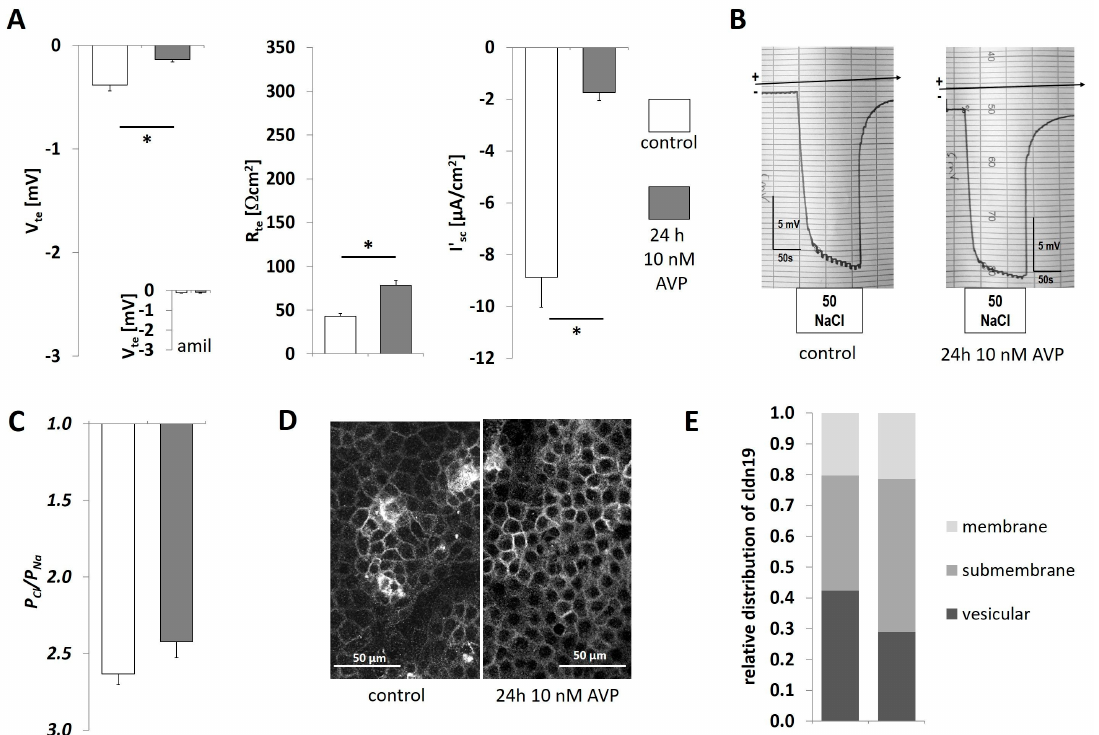
Figure 4. 600-IMCD under AVP stimulation (10 nmol/L). ( A ) Electrophysiological properties with transepithelial voltage V te , transepithelial resistance R te , and equivalent short-circuit current I’ sc , with or without 24 h prestimulation with AVP. Insert in V te panel: V te in the presence of 50 µM amiloride. ( B ) Original experiments showing 50 mmol/L NaCl diffusion potentials, ( C ) summarized permeability ratio P Cl /P Na . Data are means ± SEM, n = 12,12; * p < 0.05. ( D ) Immunofluorescence of claudin-19 in 600-IMCD, ( E ) summarized subcellular localization of claudin-19 in the categories of membrane TJ staining, submembrane and intracellular vesicular staining, n = 8, 7.